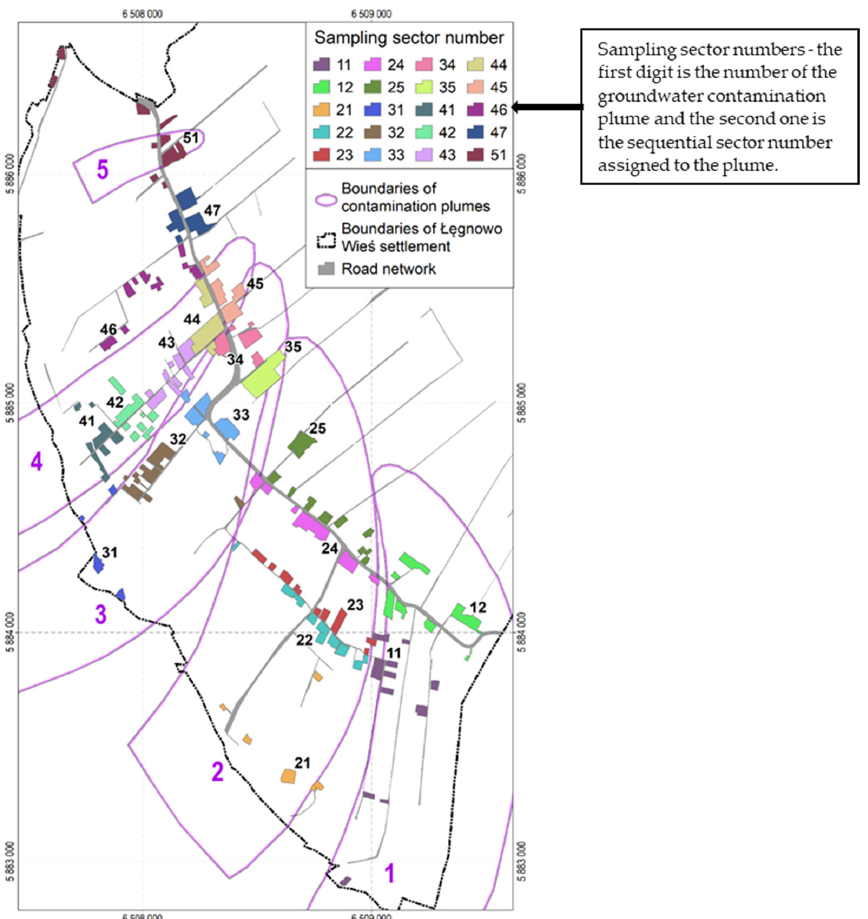
Figure 3. Location of soil sampling sectors in the residential development area of ŁWS against the background of groundwater contamination plumes (based on Czop et al. [37].